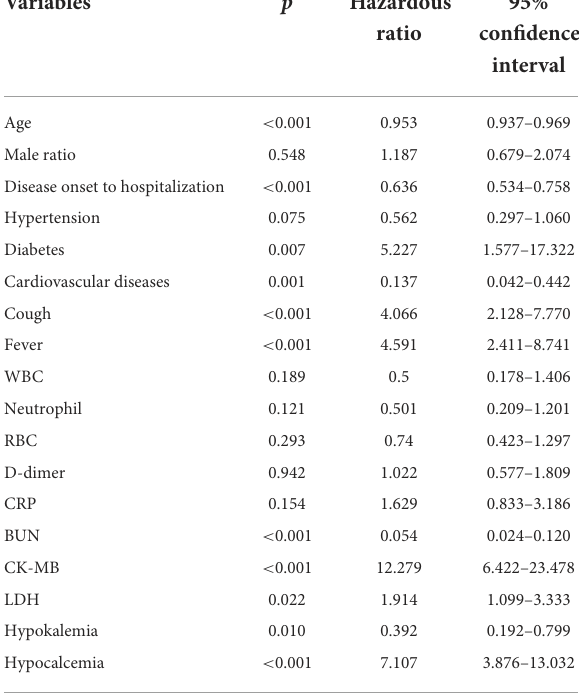
TABLE 3 Variables ( p < 0.05) with clinical relevance were performed using multivariate logistic regression analysis to explore the independent risk factors associated with differences between the influenza cohort and the COVID-19